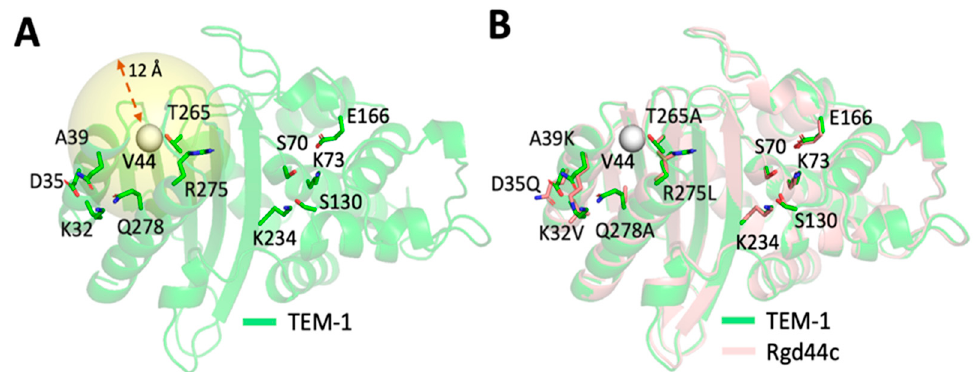
Figure 3. Our general computational protein design strategy is shown schematically using the designed protein Rgd44c as an example. ( A ) Residues within an 8–12 Å sphere surrounding a given residue (V44 in this example) are considered as candidates for mutation. ( B ) A combination of mutations surrounding the target residue are generated using the RosettaDesign algorithm and scored using the Rosetta energy function. An overlay of the Rgd44c design model with TEM-1 ( B ) indicates that this design protocol creates a diversity of mutations within the design sphere while leaving active site residues untouched. The target rigid residue (V44) is shown as a white sphere in both panels. Both catalytic and designed residues are shown as sticks.